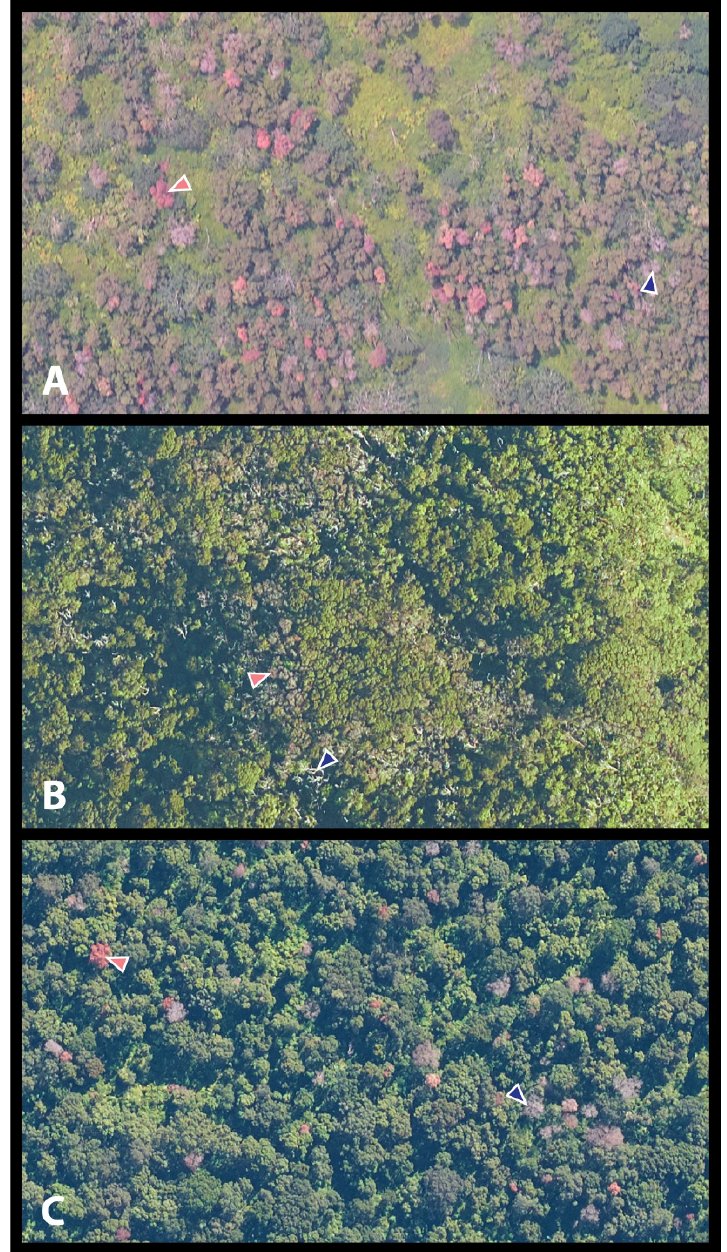
Figure 1. Example images from the Carnegie Airborne Observatory high-resolution digital camera showing suspected ROD-infected brown-state crowns along with nearby leafless crowns. Such regions were used as training and validation data. Scenes are from the regions of Puna ( A ), Kohala ( B ), and Kona ( C ). Light red arrows point to example brown-state trees and dark blue arrows point to example leafless